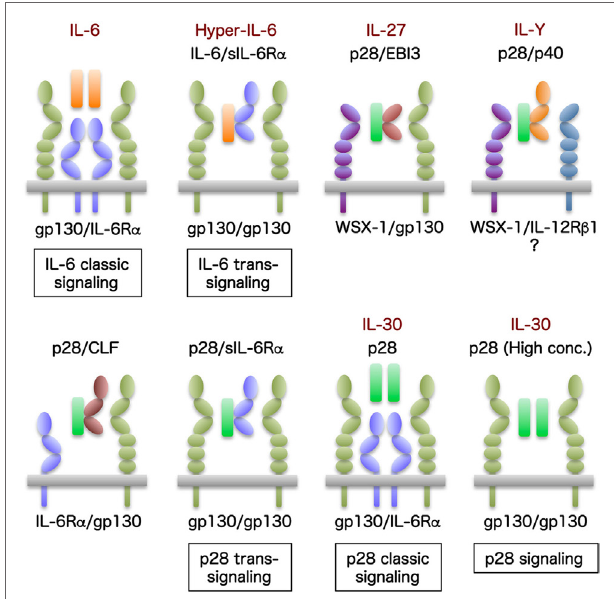
FiguRe 4 | iL-30 and its related molecules . IL-6 is unique in signaling through not only membrane-bound IL-6R α but also sIL-6R α . The former is called IL-6 classic signaling through membrane-bound IL-6R α together with gp130, and the latter is called IL-6 trans -signaling by IL-6 bound with sIL-6R α and IL-6/sIL-6R α (also designated Hyper-IL-6) through only gp130. The α subunit of IL-27, p28, which is referred to as IL-30, functions as an agonistic cytokine via the gp130 signaling pathway similar to IL-6, either by itself or associating with other molecules such as IL-12p40, CLF, IL-6R α , forming p28/IL-6R α classic signaling, p28/sIL-6R α trans -signaling, and p28 signaling. Moreover, p28 can activate signal transduction via gp130, even in the absence of IL-6R α or EBI3, albeit at higher